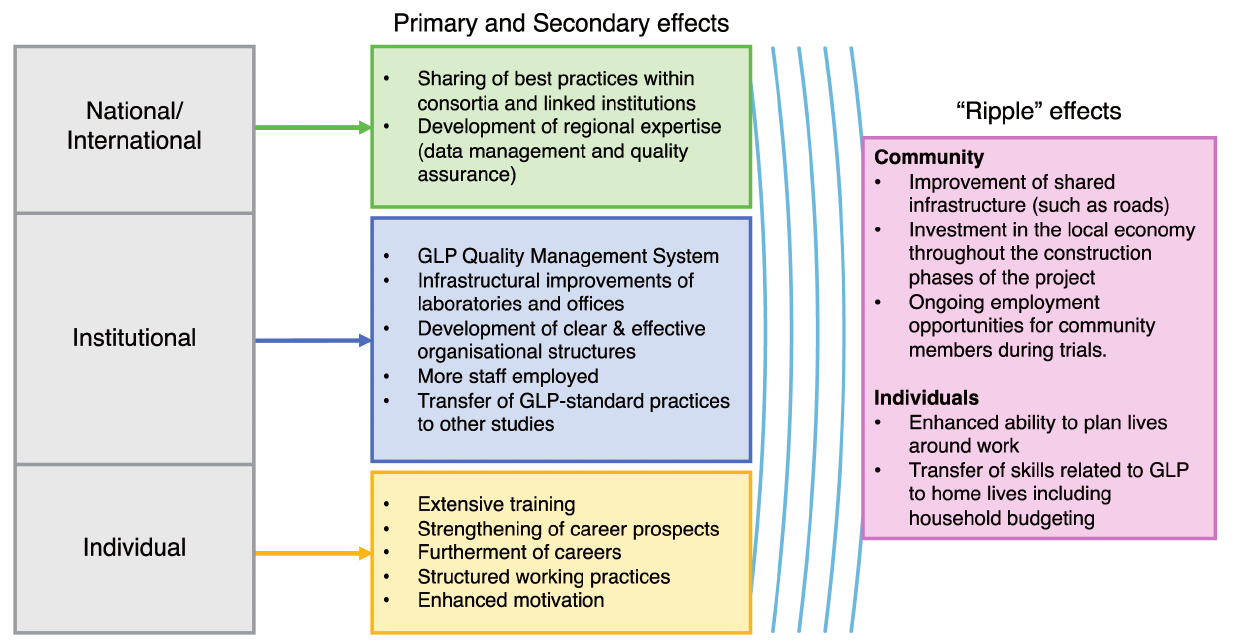
Figure 1. Summary of research capacity effect at the individual, institutional and national/international levels.